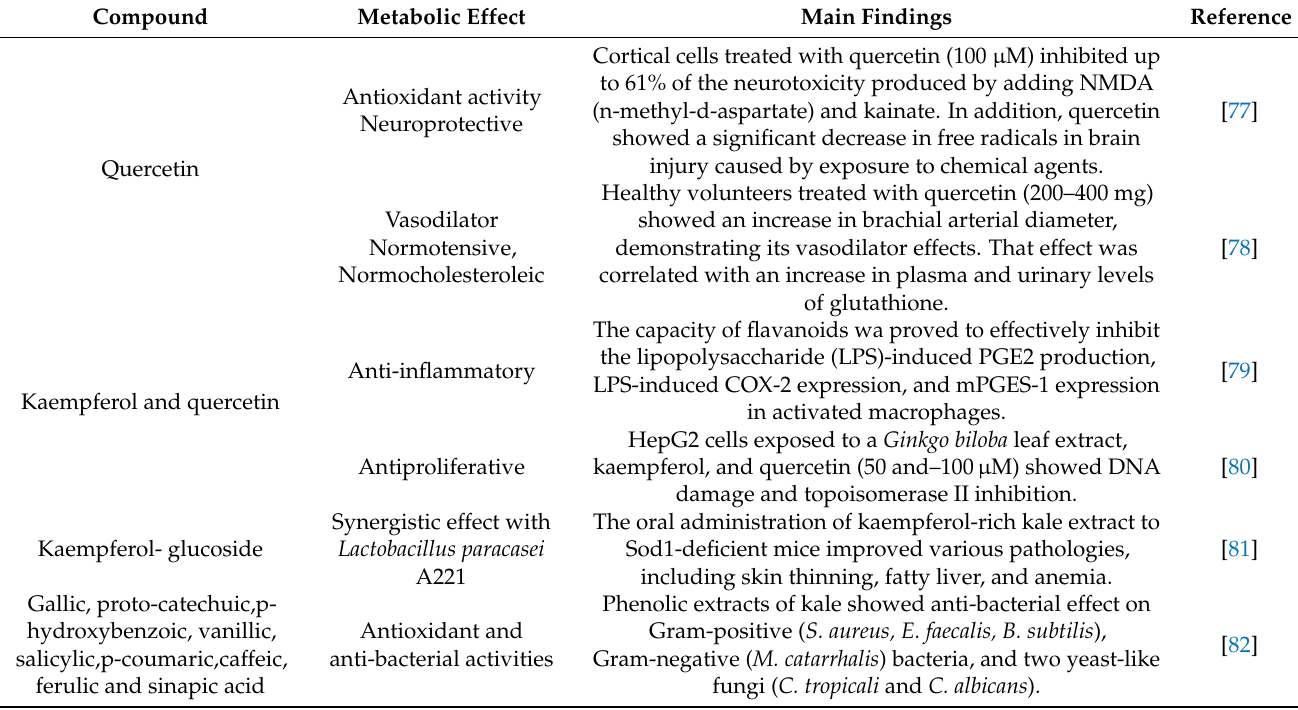
Table 3. Health benefits of the main phenolic compounds found in kale, determined through in vivo and in vitro studies.